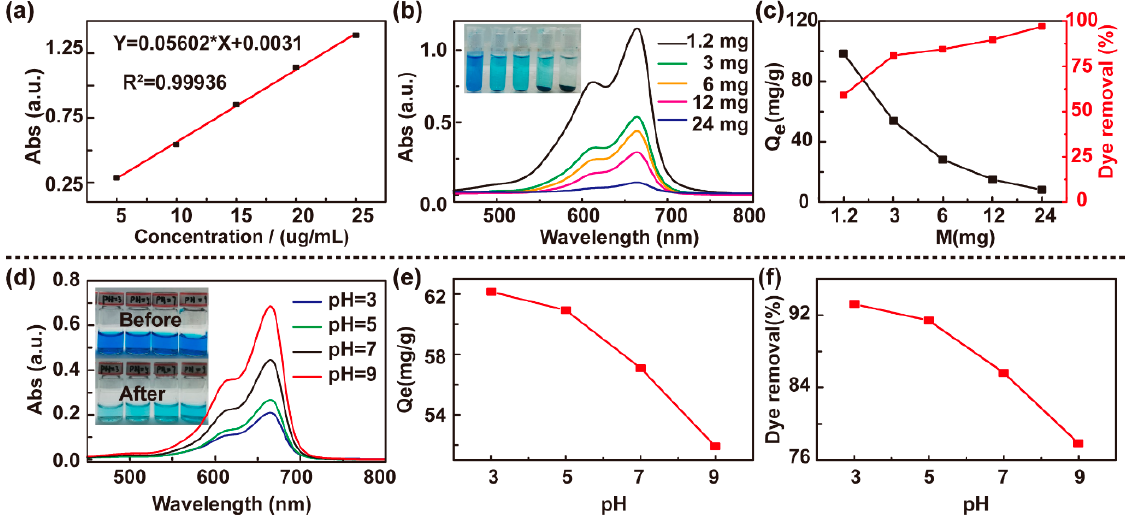
Figure 3. Influence of adsorbent quality and pH value on adsorption effect. ( a ) Methylene blue (MB) standard curve. ( b ) UV–vis spectra corresponding to the study of the adsorption of MB by PMAA/GO composite hydrogel of different masses. ( c ) The adsorption capacity (Qe) and dye removal of different mass. ( d ) The UV–vis spectra corresponding to the solutions of different pH values. ( e ) The relationship between the pH of the solution and the adsorption capacity. ( f ) The relationship between the pH value of the solution and the removal rate.